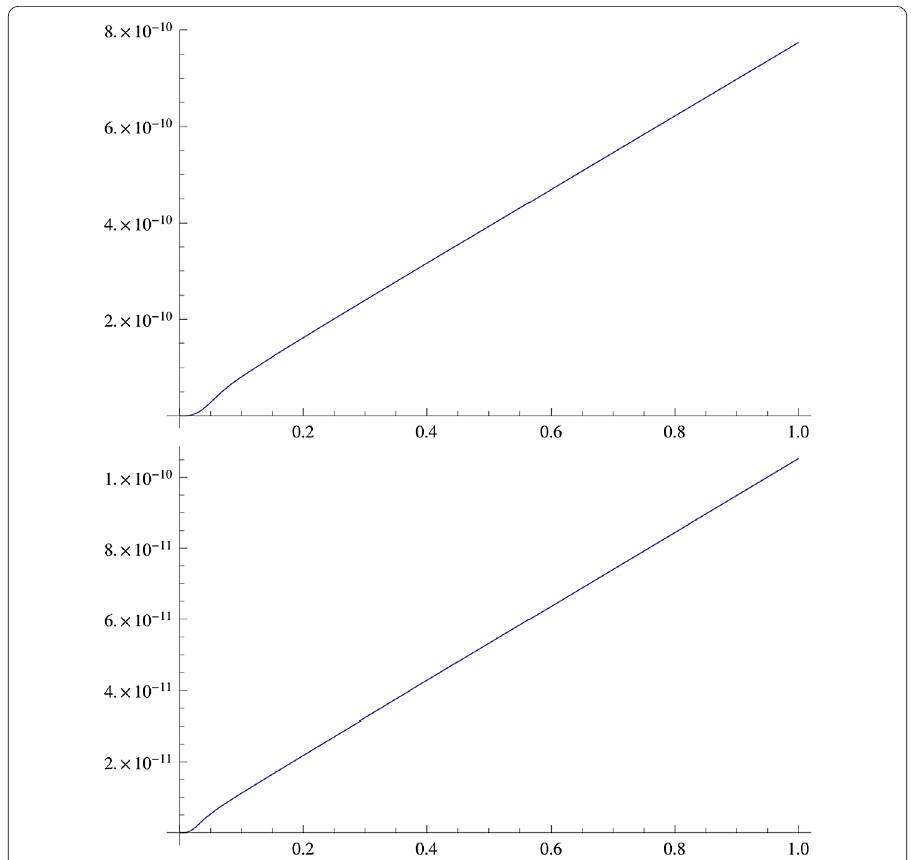
N Method in [5] RKHSM (Present method)